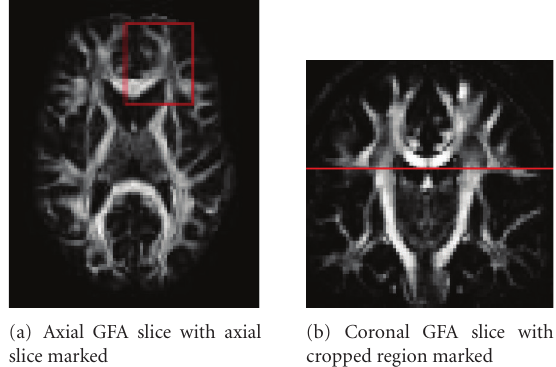
Figure 6: Generalized fractional anisotropy axial, Figure 6(a), and coronal, Figure 6(b) slices in the real